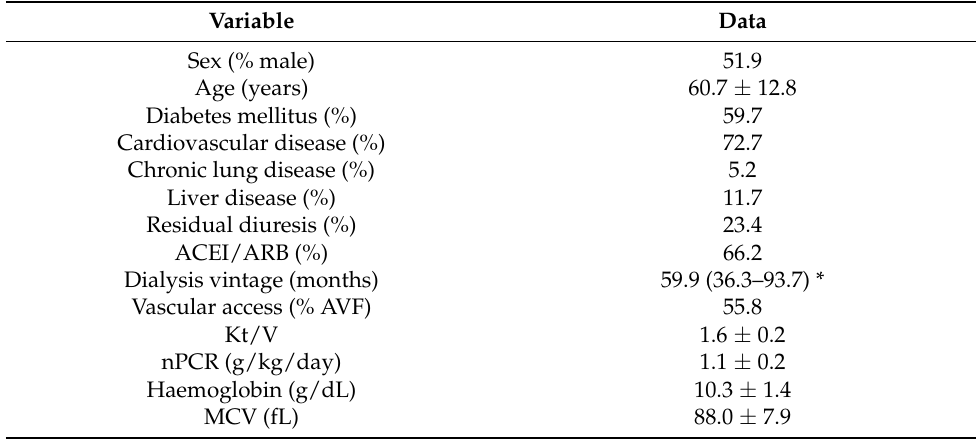
Figure 1. Participants flow chart in this study. Table 1. Characteristics of the overall study